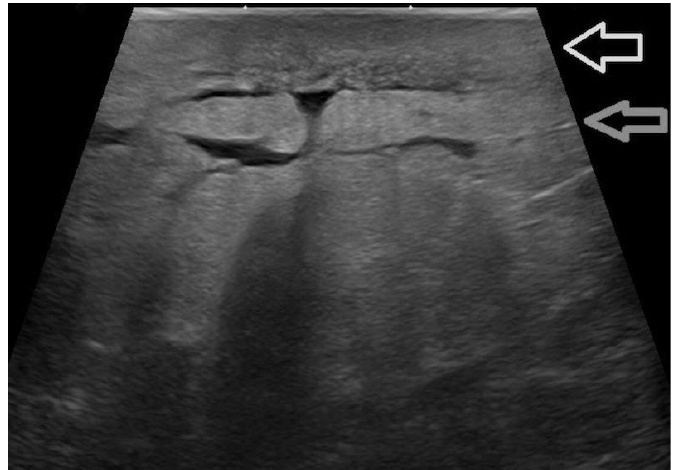
Figure 3. Skin thickening after conservative breast surgery and adjuvant irradiation. Imaging at 22 MHz allowed an optimal depiction of the thickened dermis (white arrow) and hypodermis (gray arrow).